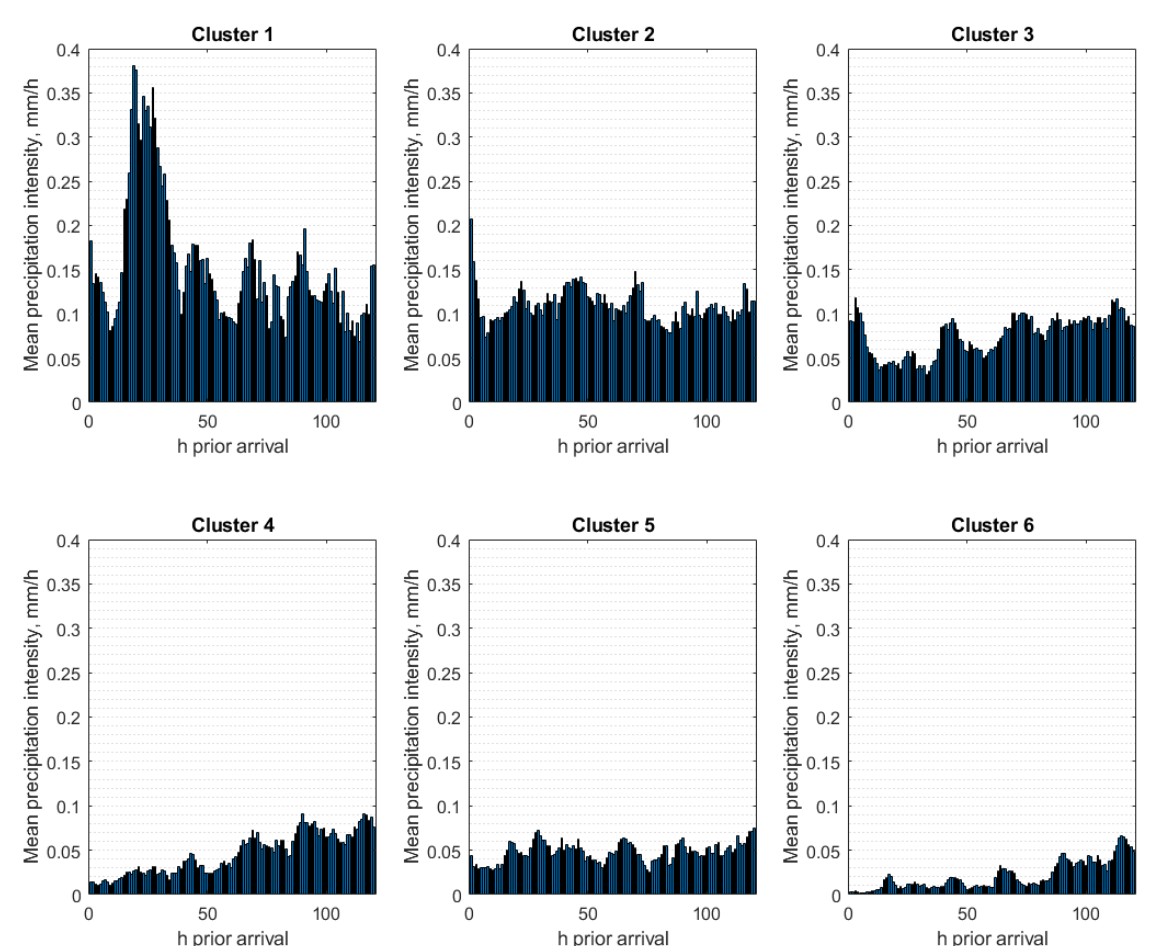
Figure 16. Mean precipitation along the transport of cluster 1 to 6.